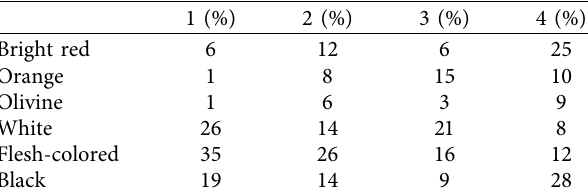
Table 5: Satisfaction survey situation.